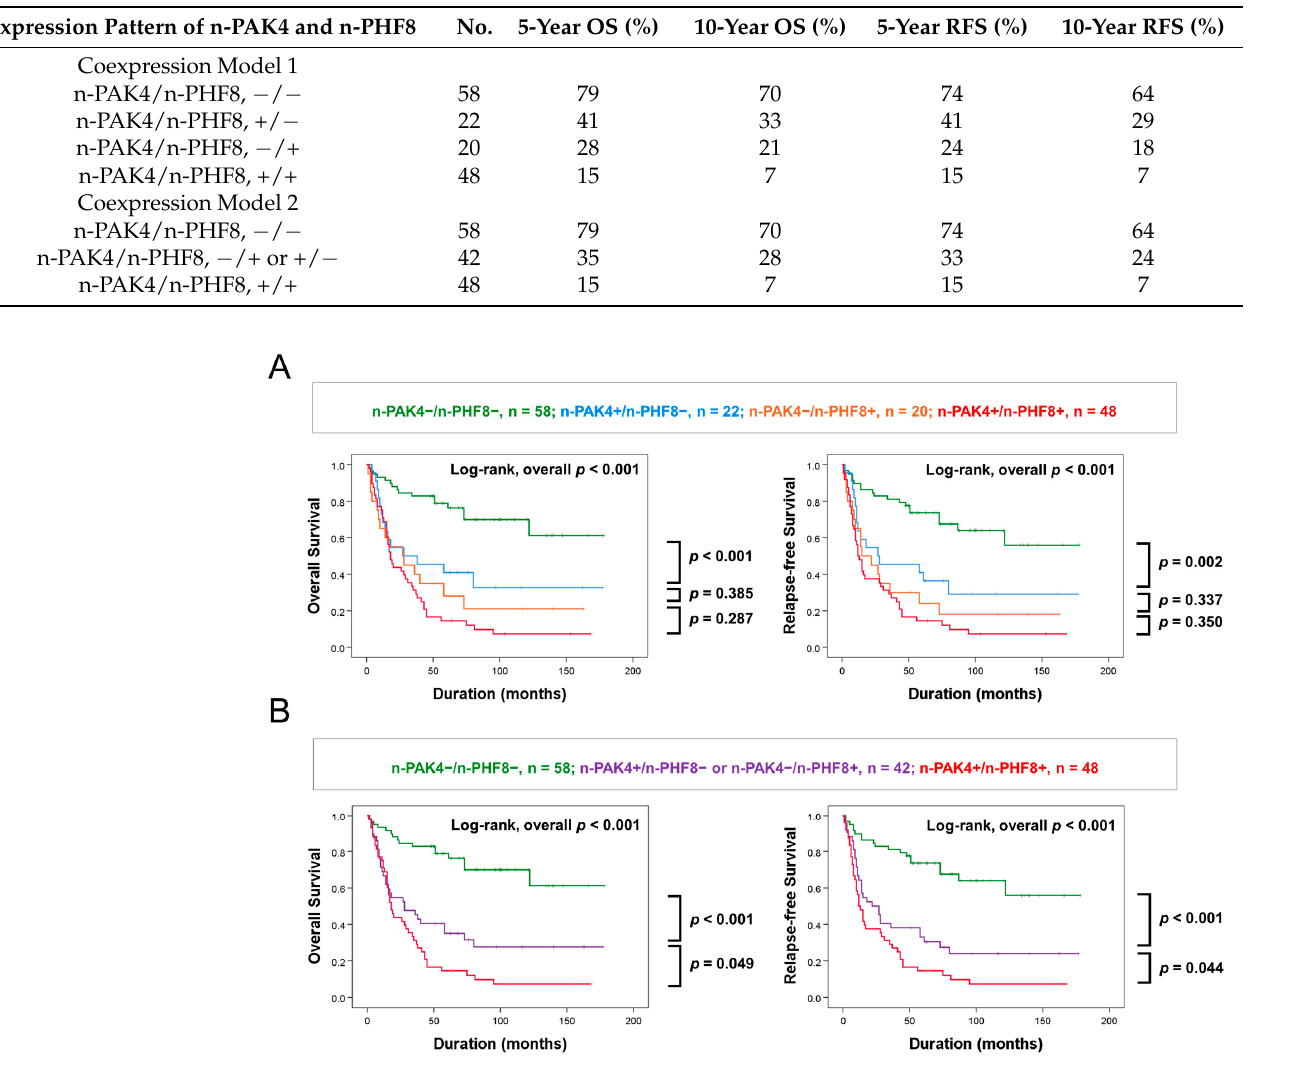
Figure 3. Kaplan–Meier survival analysis according to the combined expression pattern of n-PAK4 and n-PHF8. ( A ) Kaplan–Meier survival curves in four prognostic subgroups of GBCs according to the combined expression pattern of n-PAK4 and n-PHF8: [n-PAK4 − /n-PHF8 − ], [n-PAK4 + /n-PHF8 − ], [n-PAK4 − /n-PHF8 + ], and [n-PAK4 + /n-PHF8 + ] subgroups. ( B ) Survival analysis in three prognostic subgroups of GBCs: [n-PAK4 − /n-PHF8 − ], [n-PAK4 + /n-PHF8 - or n-PAK4 − /n-PHF8 + ], and [n-PAK4 + /n-PHF8 + ] subgroups. Table 5. Univariate and multivariate Cox regression analysis according to coexpression patterns of n-PAK4 and n-PHF8 in GBCs.